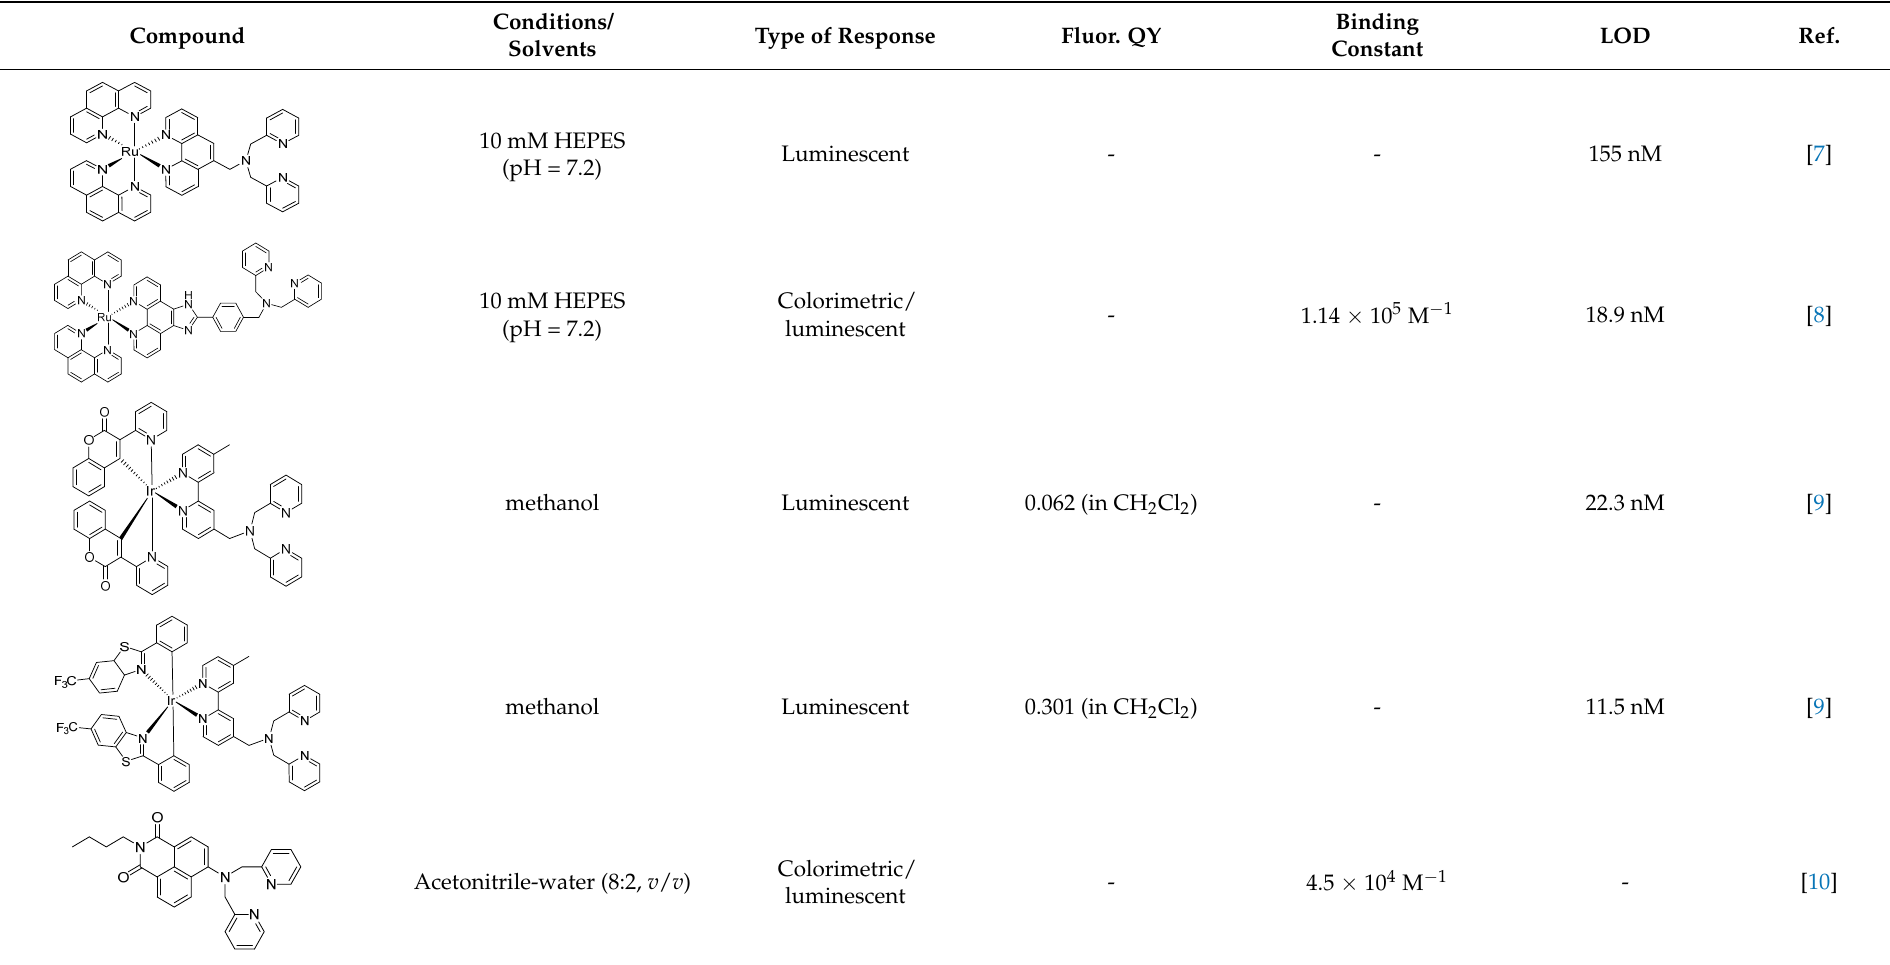
Table 1. Comparison between different DPA chemosensors towards copper (II).